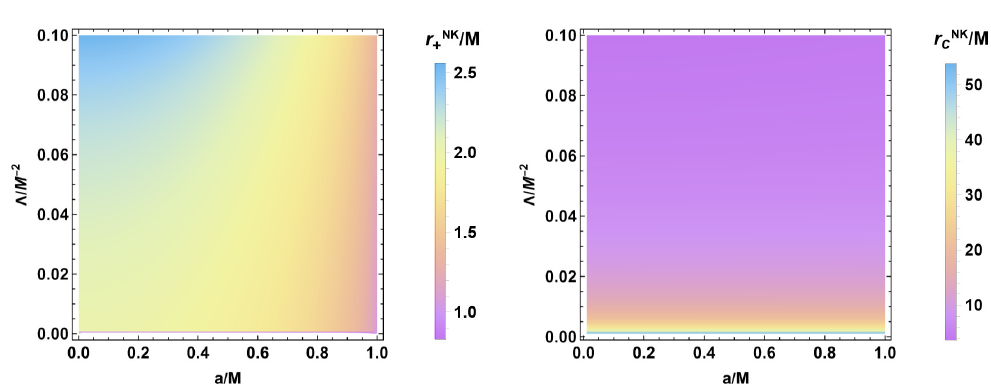
Figure 3. Density plot of event horizon ( left ) and cosmological horizon ( right ) of the new Kerr–de Sitter black holes shown in parameter space. For a given a and Λ , we can uniquely determine the horizons.